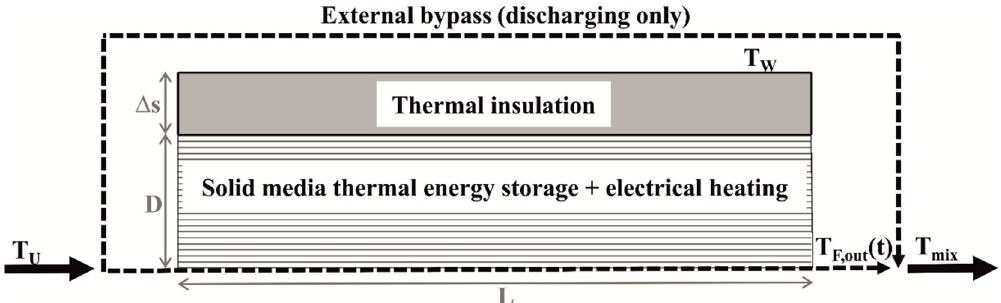
Figure 1. Reference concept—electrical heated solid media thermal energy storage with external bypass for discharging operation ( D/L —storage medium diameter/length; ∆ s —thermal insulation thickness).